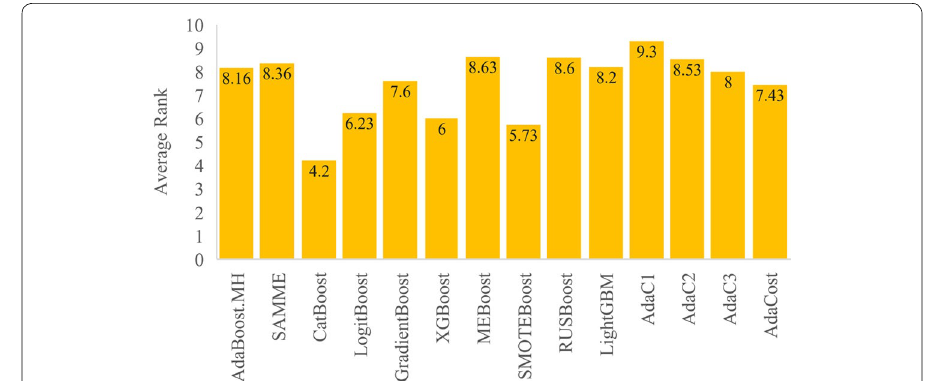
Fig. 2 Average ranks obtained from Friedman test based on the MAUC